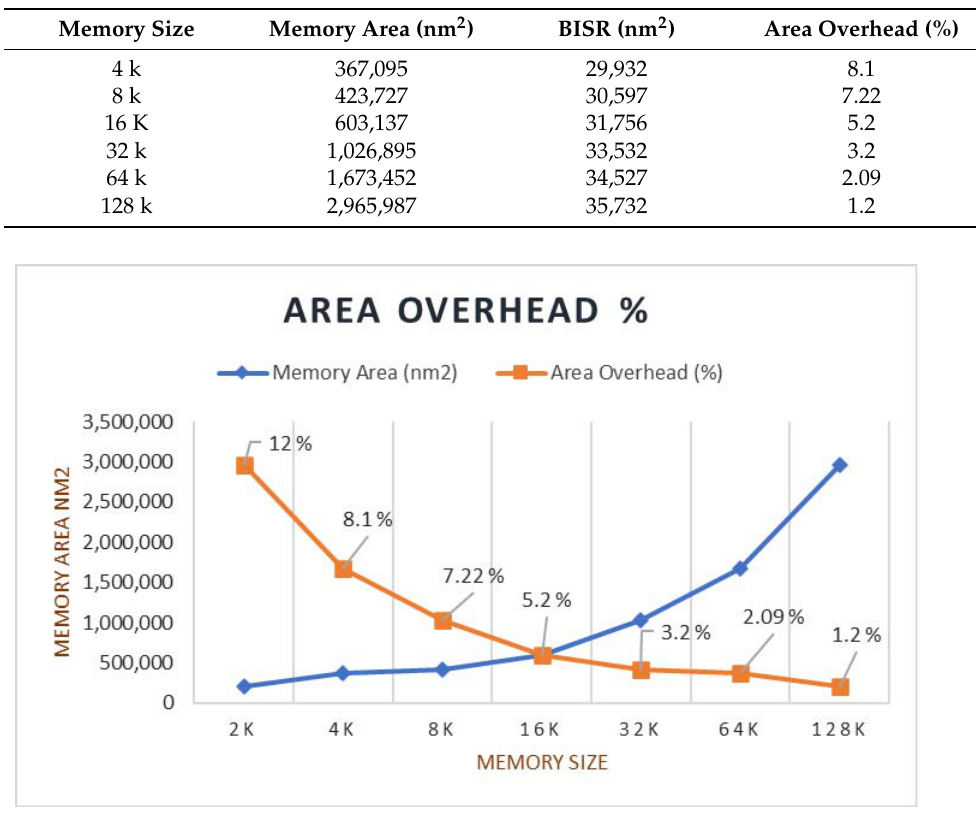
Figure 9. Different memory models versus BISR area overhead.